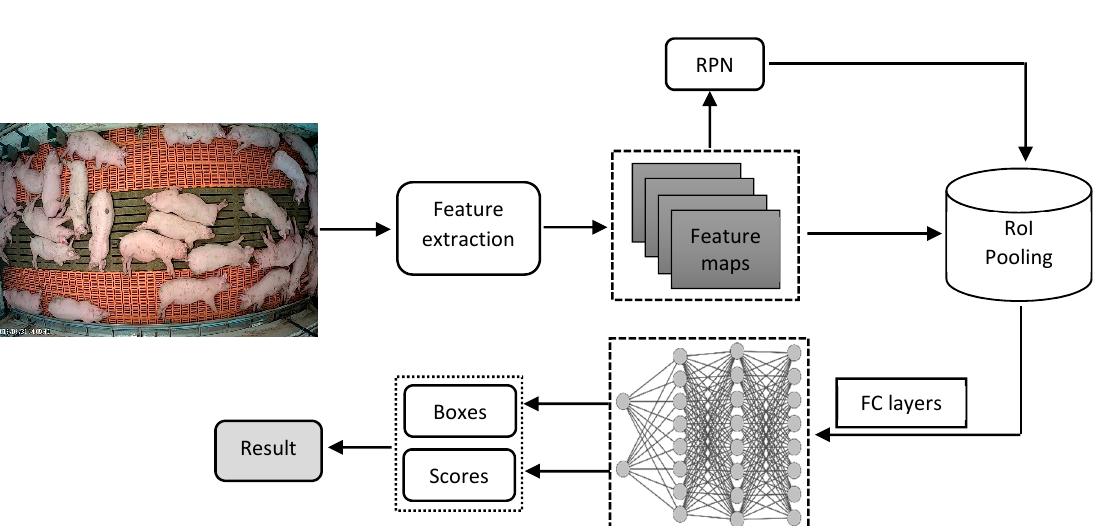
Figure 3. Schematic diagram of the faster regions with convolutional neural network (Faster R-CNN) used in this study.